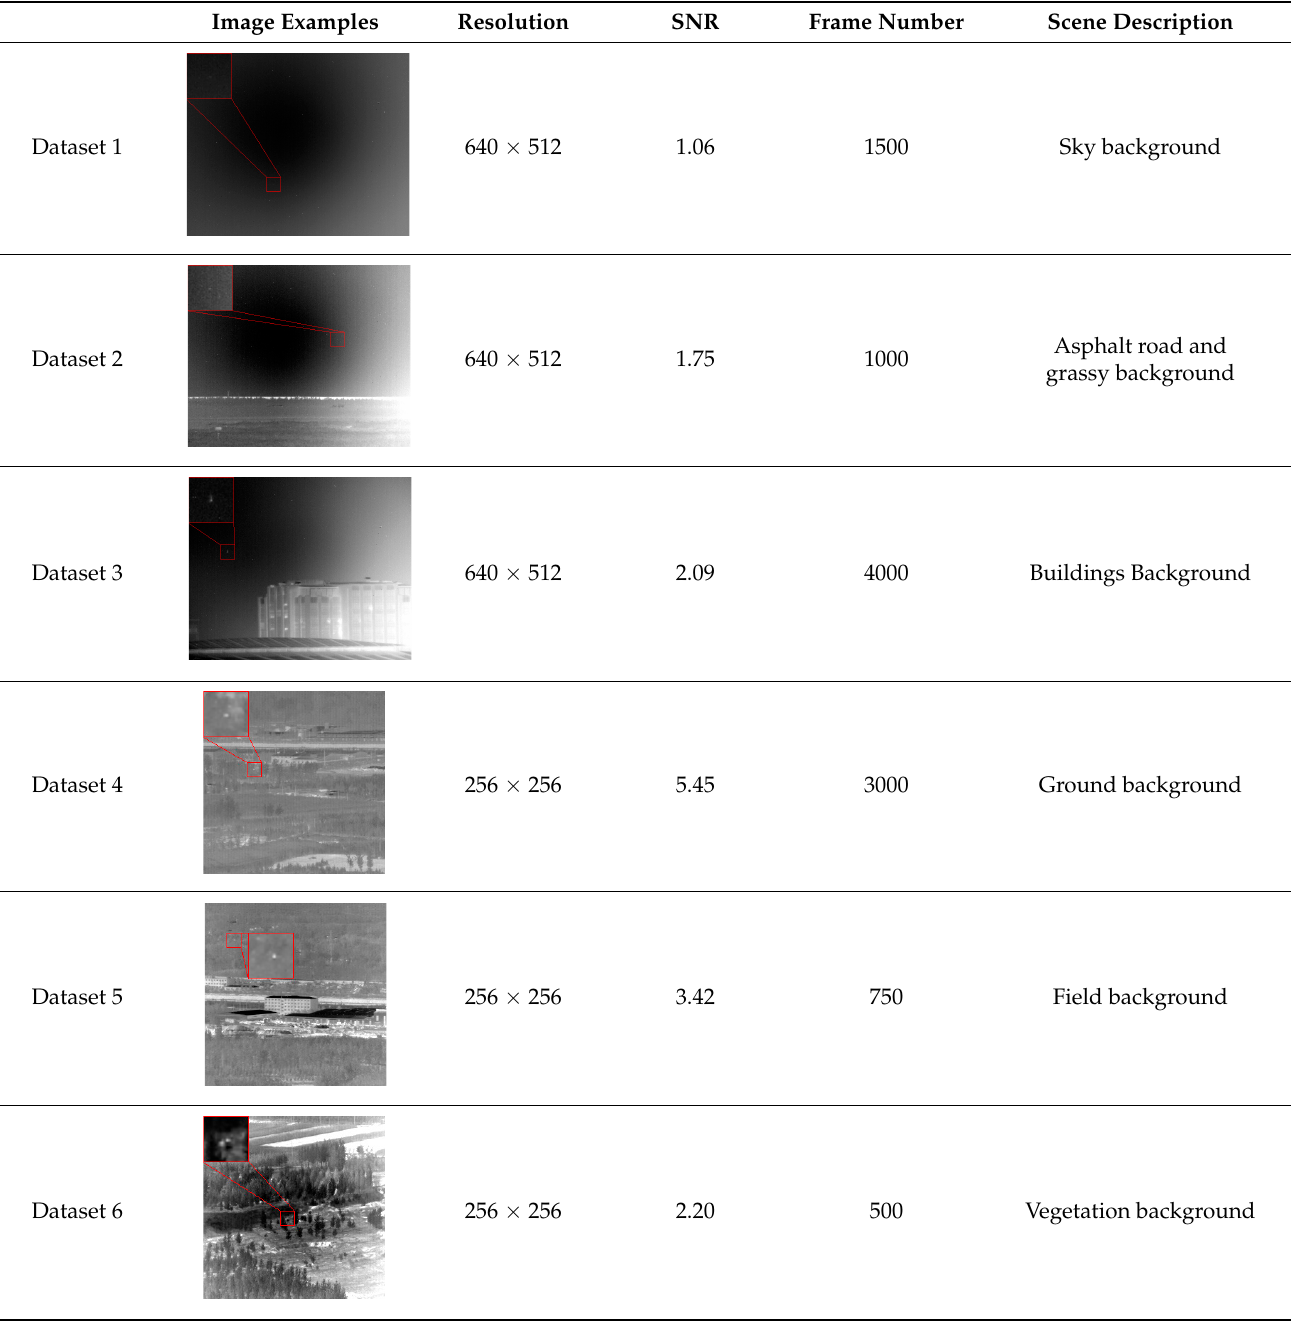
Table 1. Details about 6 representative datasets.